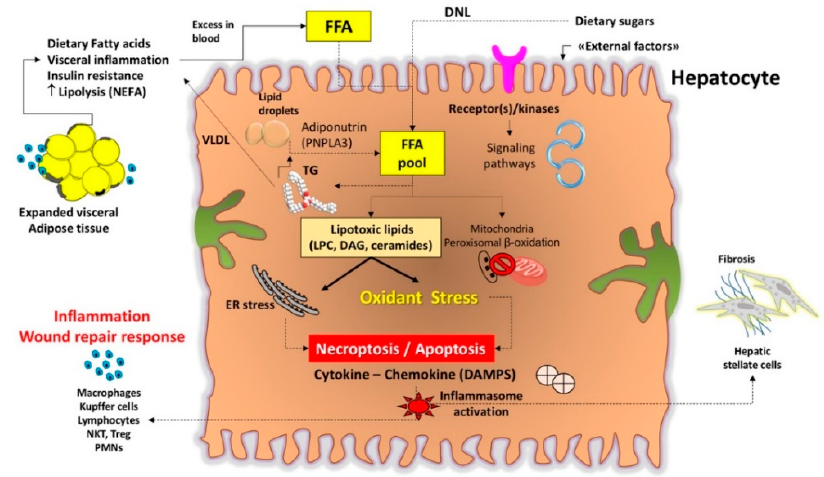
Figure 4. Mechanisms of lipotoxicity in the liver. Excessive accumulation of free fatty acids (FFA) is the result of increased influx, increased synthesis, decreased mitochondrial oxidation of FFA, or decreased secretion / export of FFA. Adiponutrin (also known as patatin-like phospholipase domain-containing protein 3, PNLPA3) governs the lipolysis of lipid droplets with FA flowing back to the hepatocyte FFA pool. With excess FFA, their disposal through beta-oxidation or formation of triglyceride is insu ffi cient and lipotoxic species form (Lysophosphatidylcholine, LPC; diacylglycerol, DAG; ceramides) that mediate endoplasmic reticulum (ER) stress, oxidant stress and activation of the inflammasome (the multiprotein cytoplasmic complex that responds to damage-associated molecular patterns (DAMPs), as part of the innate immunity response). External factors, poorly understood so far, may include dysregulation of cytokines and adipokines, ATP depletion, toxic uric acid, sleep apnea leading to periodic hypoxia, and products of the gut microbiome (tumor necrosis factor (TNFa), endogenous ethanol, and endotoxins like lipopolysaccharides (LPS)). Such events promote the phenotype of NASH, hepatocellular injury, inflammation, stellate cell activation, and progressive accumulation of excess extracellular matrix. Further target structures of damage are other intracellular organelles, the nucleus, receptors and signaling pathways. See also